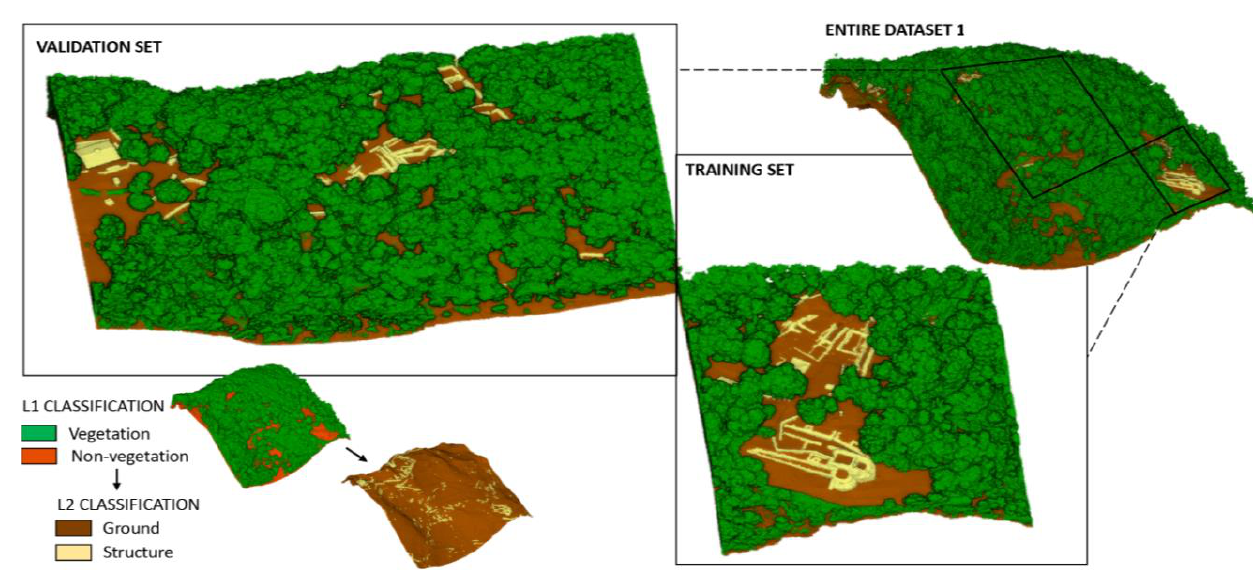
Figure 3. Training, validation and test sets for Dataset_1 ( San Martino ai Campi archaeological area).